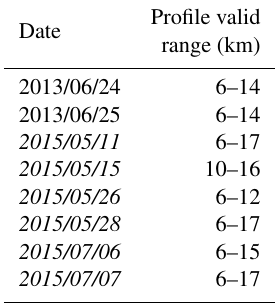
Table 2. Dates of comparisons with collocated ECC soundings and corresponding LIO3T O 3 profile valid ranges. Italicized dates indi- cate profiles impacted by the Calbuco eruption.